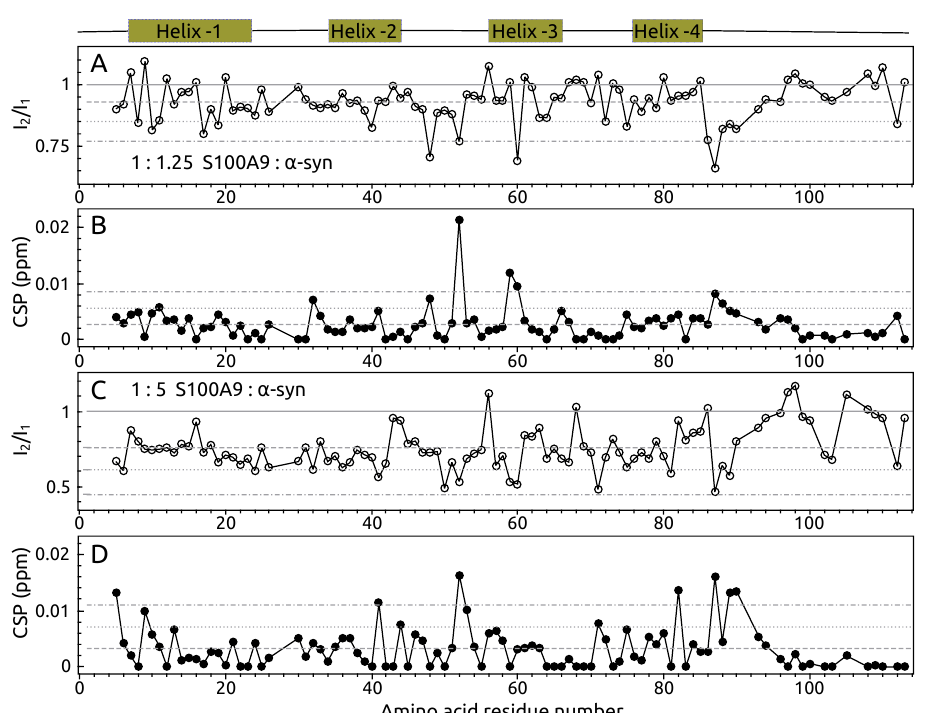
Figure 3. ( A , C ) Intensity change and ( B , C ) chemical shift perturbation (CSP) of S100A9 after addition of α -syn (molar ratio ( A , B ) 1:1.25 and ( C , D ) 1:5 of S100A9: α -syn). Intensity change was expressed as the ratio of S100A9 peak intensities in the presence (I 2 ) or the absence (I 1 ) of α -syn. Horizontal gray lines: solid, dashed, dotted and dash dot correspond to starting line, when α -syn has no influence, the average, average including standard deviation (STD) and two STD of signal intensity or chemical shift change. Protein solution: 100µM 15 N S100A9, 0µM, 125µM or 500µM α -syn, 25mM HEPES, 100mM NaCl, 5mM DTT, 5mM CaCl 2 , 5% D 2 O, 0.02% sodium azide, pH